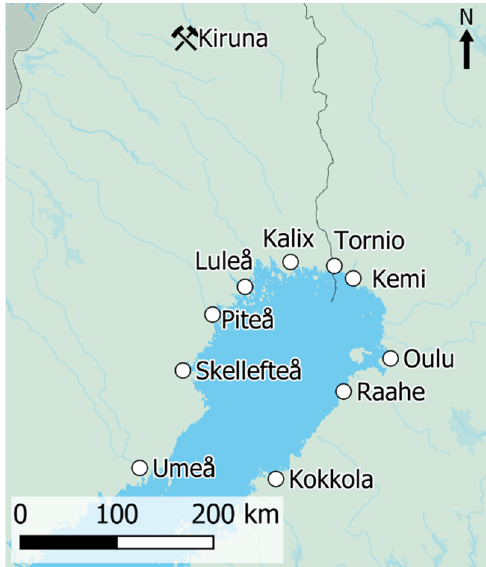
Figure 7. Major cities in the region that were included in the district heat estimation.